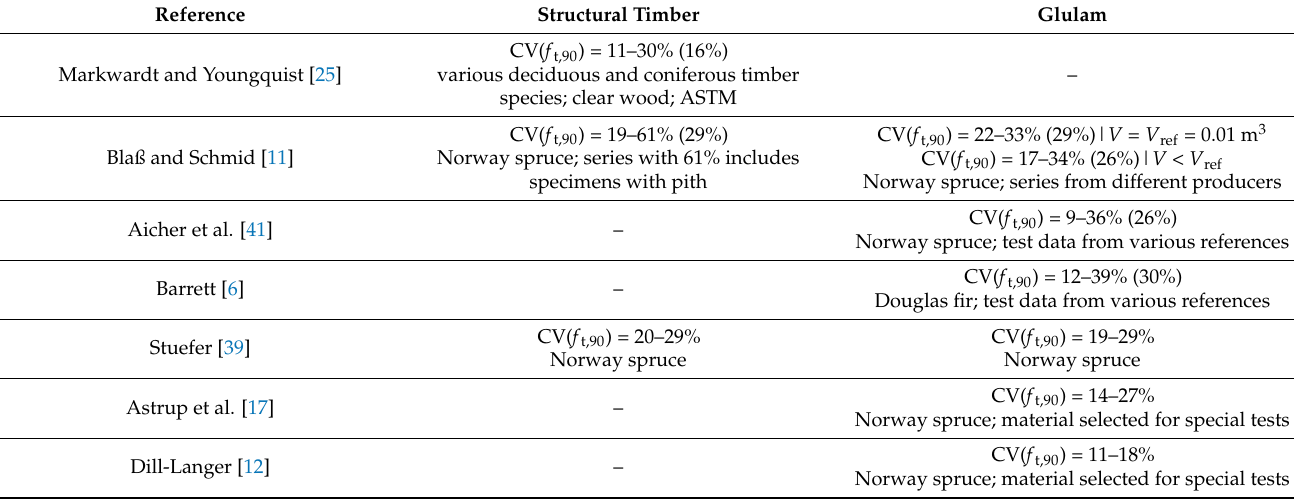
Table 1. Summary of coefficients of variation of the tensile strength perpendicular to the grain, CV( f t,90 ), gained from tests on structural timber and glulam from literature; bandwidths as observed from various series together with average values in